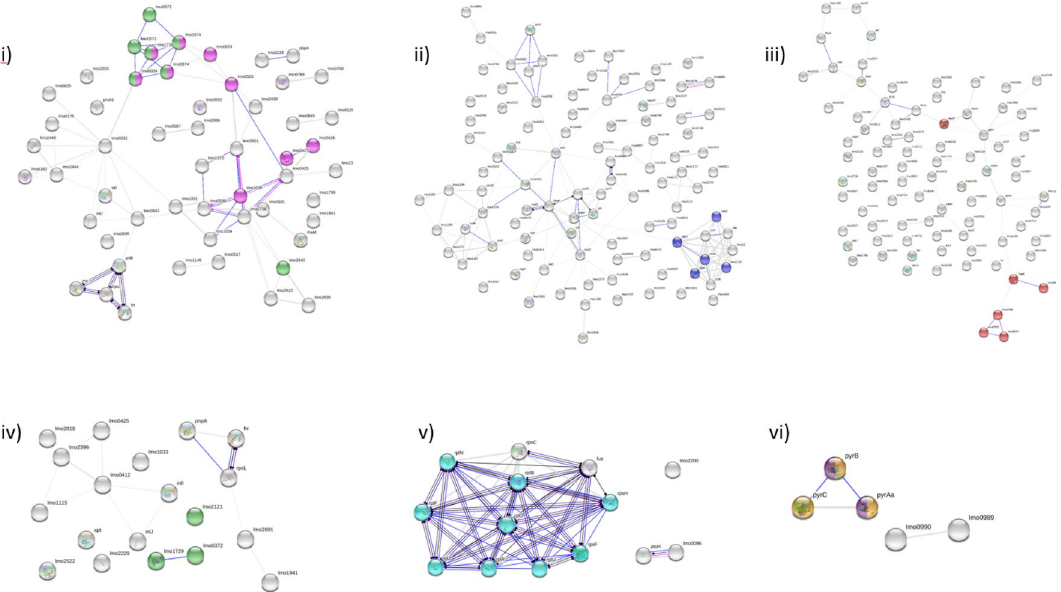
Figure 4. Overexpressed protein pathways in the transcriptome at 24 and 48 h in isolates 7453, 7545 and ST101 48 h. ( i and ii ) 7453 24 h; ( iii ) 7453 48 h; ( iv ) 7545 24 h; ( v ) 7545 48 h; ( vi ) ST101 48 h. Coloured nodes relate to overexpressed pathways: pink, phosphotransferase system; light green, starch and sucrose metabolism; dark blue, cobalamin biosynthesis; red, amino sugar and nucleotide sugar metabolism; light blue, ribosome; yellow, pyrimidine metabolism; and purple, alanine, aspartate and glutamate metabolism. Coloured lines connecting nodes relate to action type: blue, binding; black, reaction; purple, catalysis; and pink, post-translation modification. Locus tags and genes names are based upon matches to proteins in the reference genome, L. monocytogenes